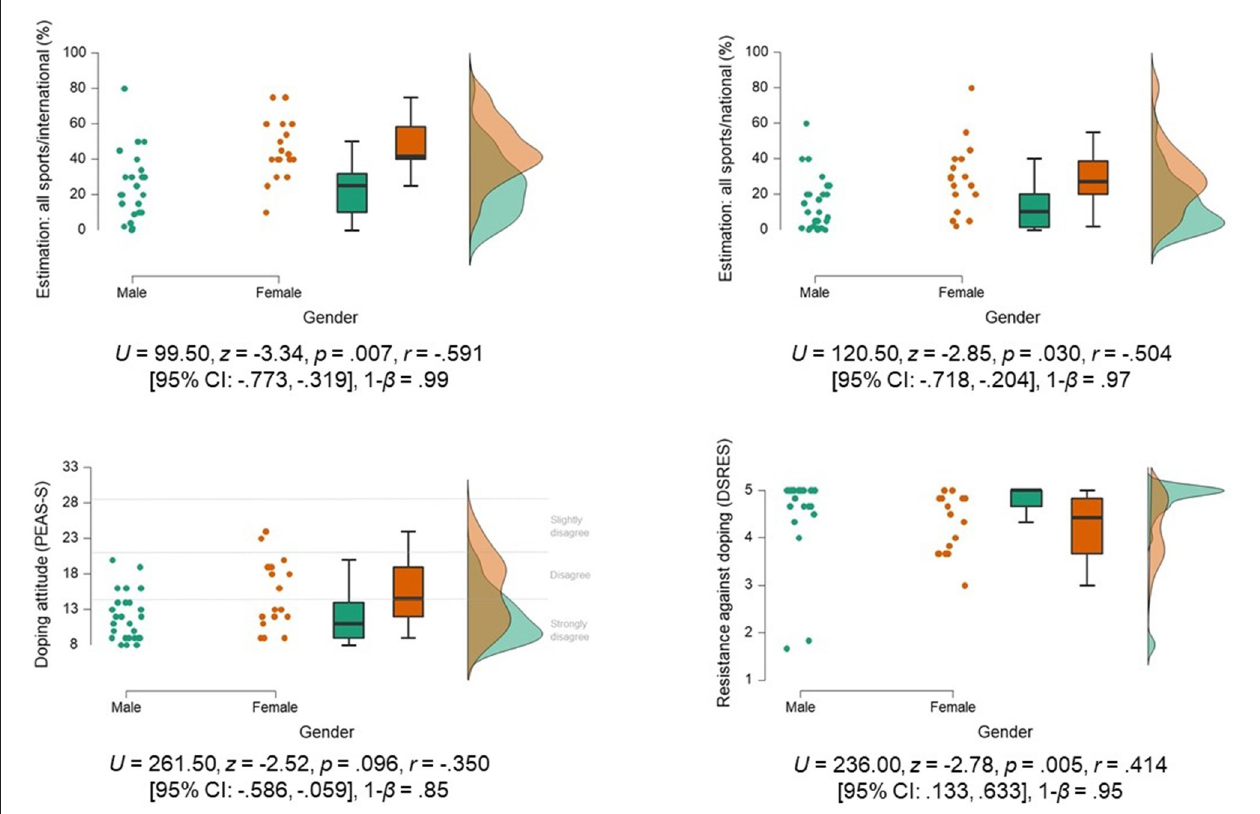
FIGURE 2 | Results of the exploratory data analysis comparing male and female athletes (significance values were adjusted by Bonferroni-Holm procedure for multiple